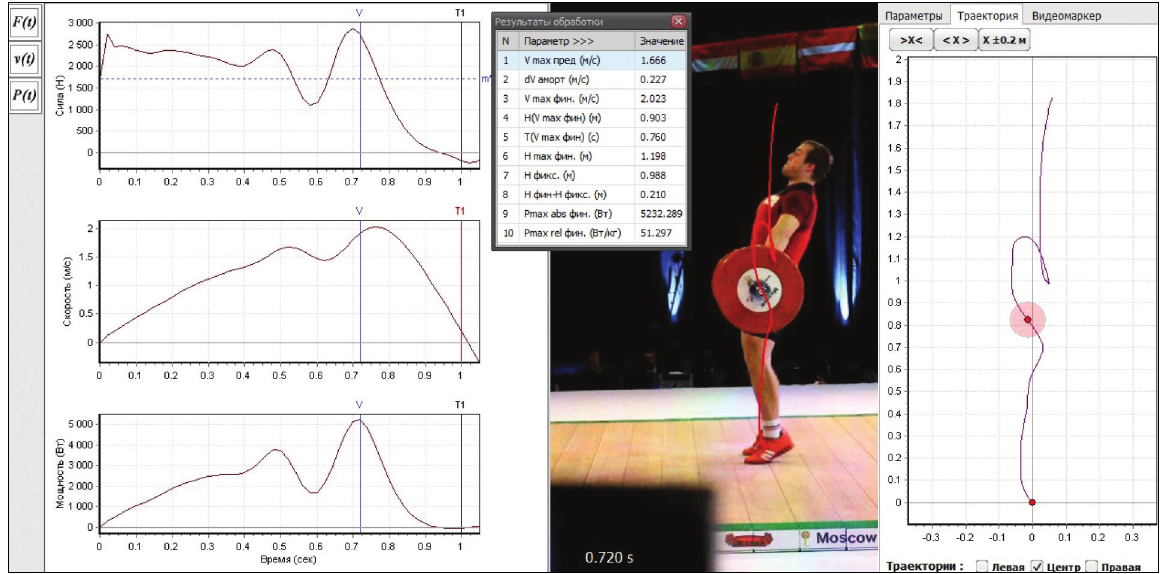
Figure 1. Kinematic and dynamic characteristics of the movement, position of the athlete at the moment of maximum power in the final acceleration, and bar trajectory in the